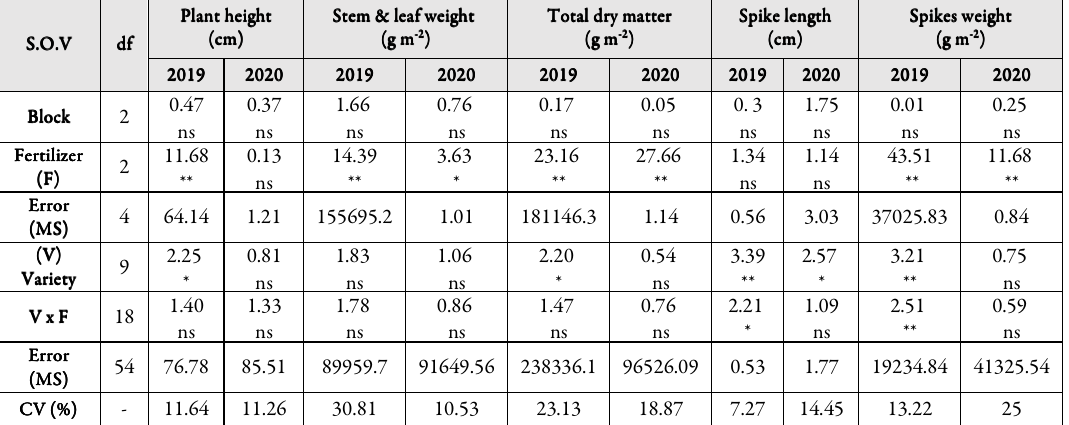
Table 2. Analysis of variances (F) for the effect of fertilization and different wheat varieties on vegetative parameters